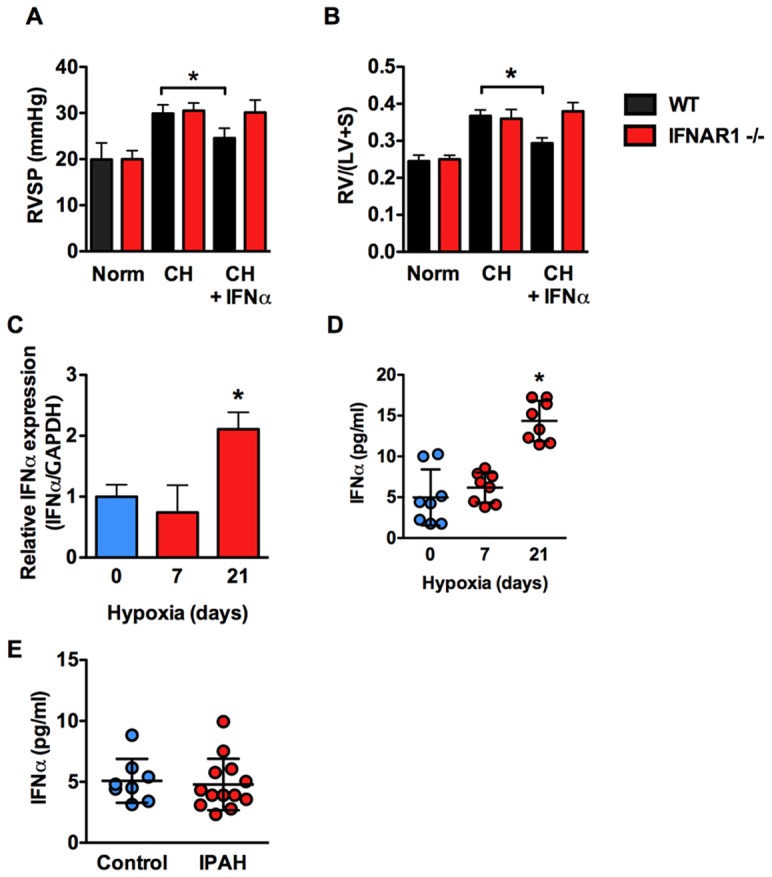
Human IFNα attenuates PH in mice in a IFNAR-dependent fashion.Effect of IFNα on (A) RVSP and (B) RVH in normoxic and hypoxic WT or IFNAR1 −/− mice (n = 6 mice per group). (C) Relative expression of IFNα (normalized to GAPDH) in total lung from C57BL/6J mice exposed to 0, 7, or 21 days of CH as determined by qRT-PCR. (D) Serum concentration of IFNα in C57BL/6J mice exposed to 0, 7, or 21 days CH as determined by ELISA. n = 8 animals per group. Analysis of variance *P<0.05. (E) Serum concentration of IFNα in control vs. IPAH human serum as determined by ELISA.